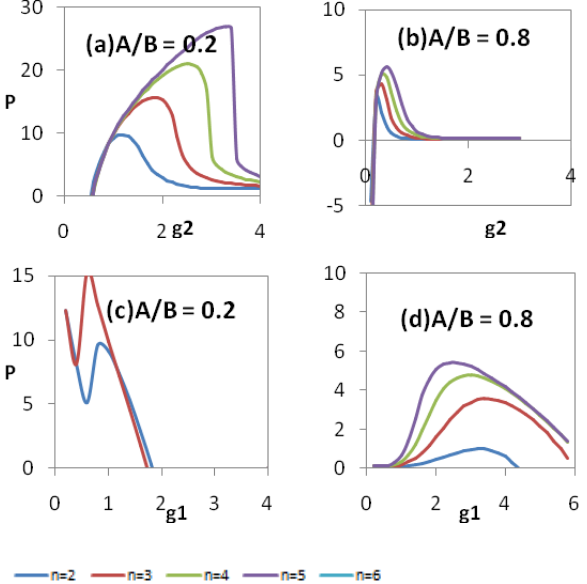
Figure 3: Effects of geometry on buckling. One layer model with growth. Zero normal and shear stress boundary condition. µ =5kPa, k 1 =1, k 2 =0.2. 𝛾 = π /6. Critical pressure at the inner radius plotted against growth rate g 1 or g 2 for various buckling